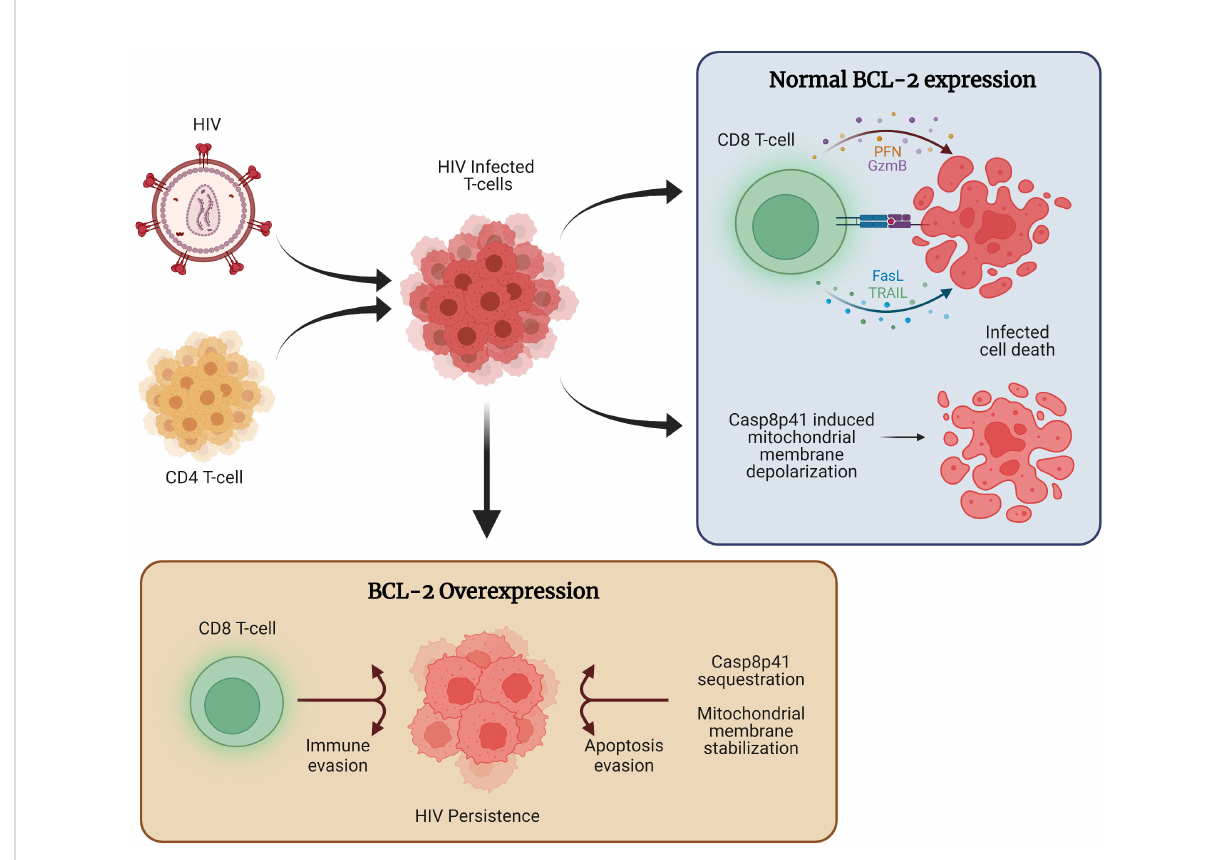
FIGURE 1 The role of BCL-2 in HIV persistence. Following HIV infection, a combination of host immune function and direct viral cytopathic effects, such as those mediated through Casp8p41 cause the majority of cells to die. However, a subset of infected cells expresses higher levels of BCL-2, allowing for apoptosis evasion and compromised immune function, ultimately allowing for the persistence of HIV infected